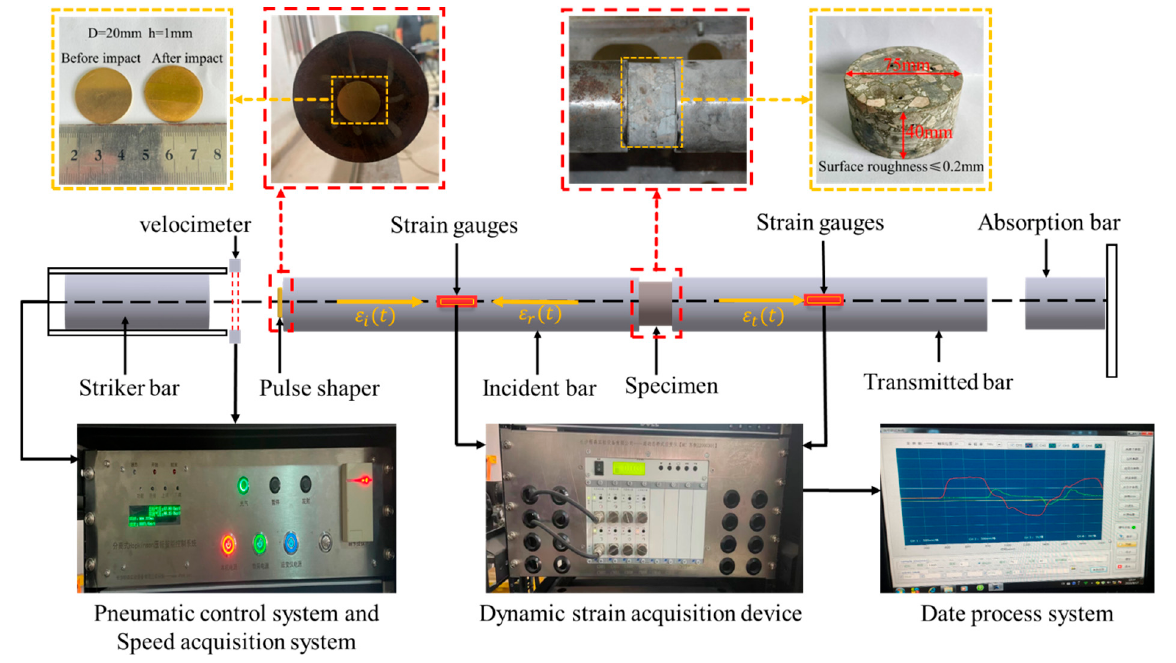
Figure 4. Schematic diagram of the SHPB test and the principle of stress wave propagation.